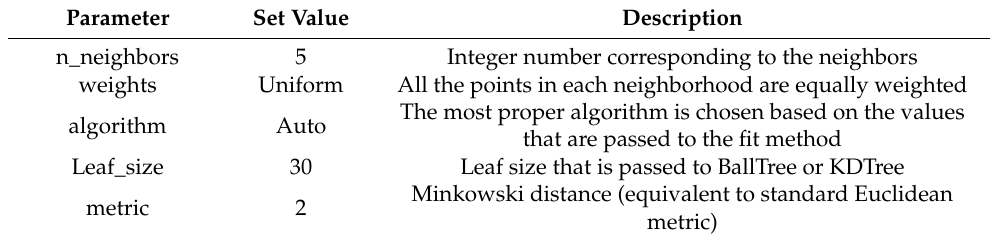
Table 9. Parameters of mechanism set for KNN.